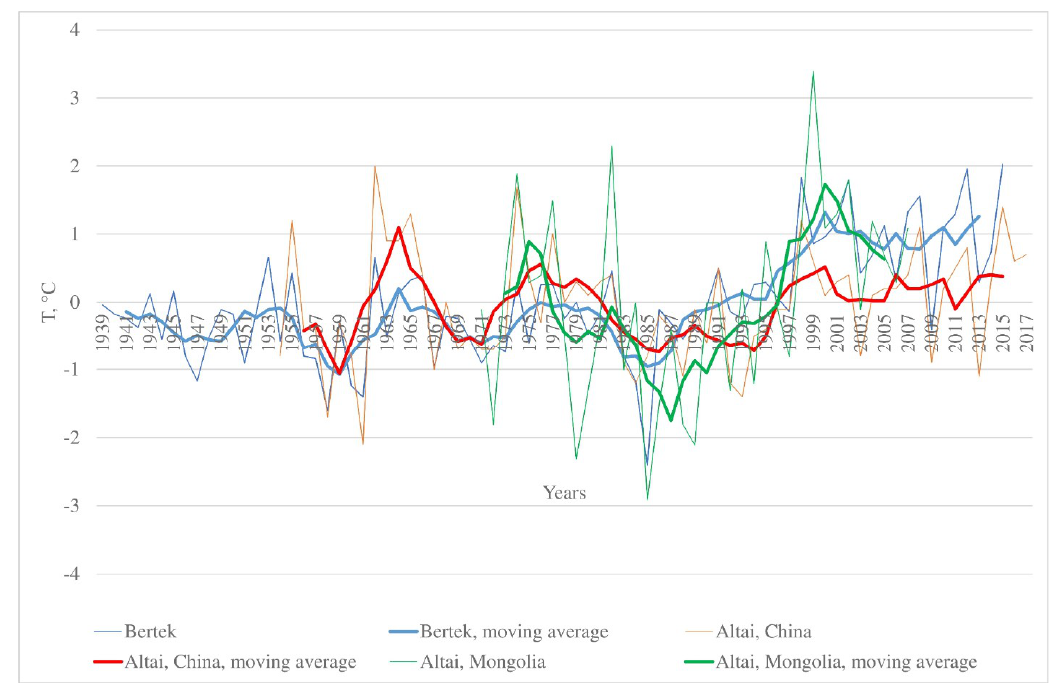
Figure 16. Changes of average summer temperature (relative to multiyear average) for three meteorologic stations of Altai and 5‑year moving average curves.